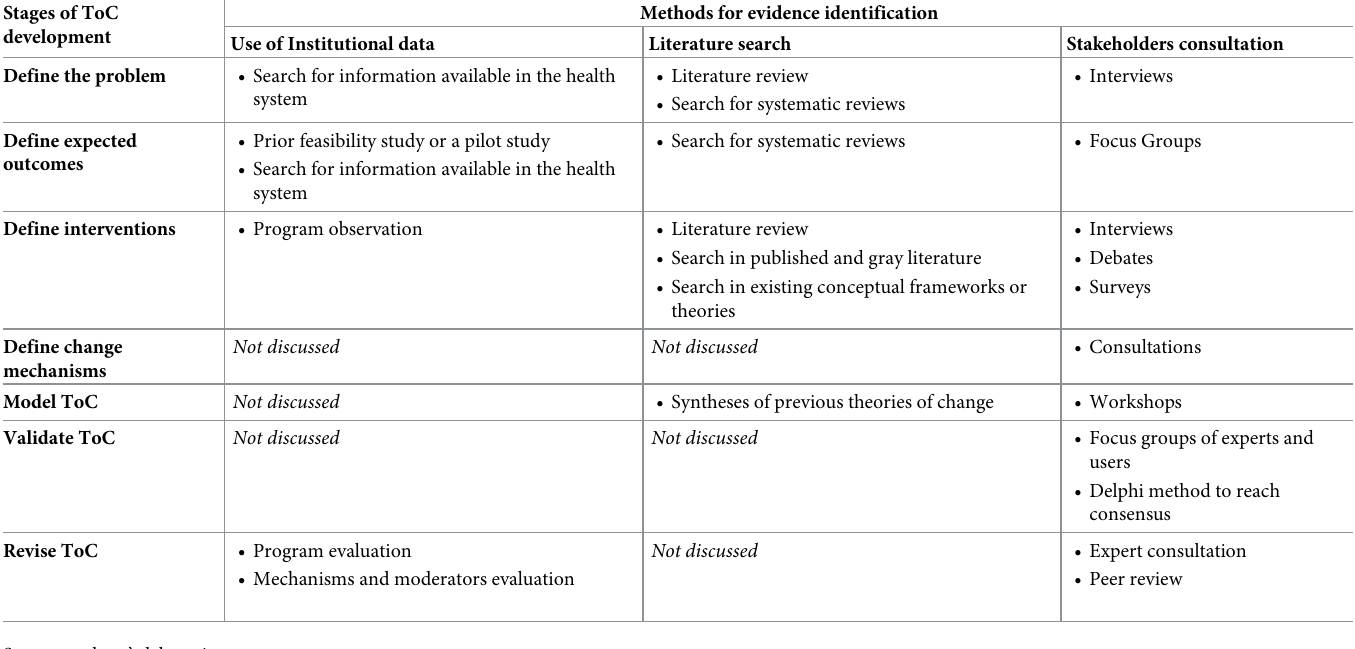
Table 6. Methods used by the included studies for evidence